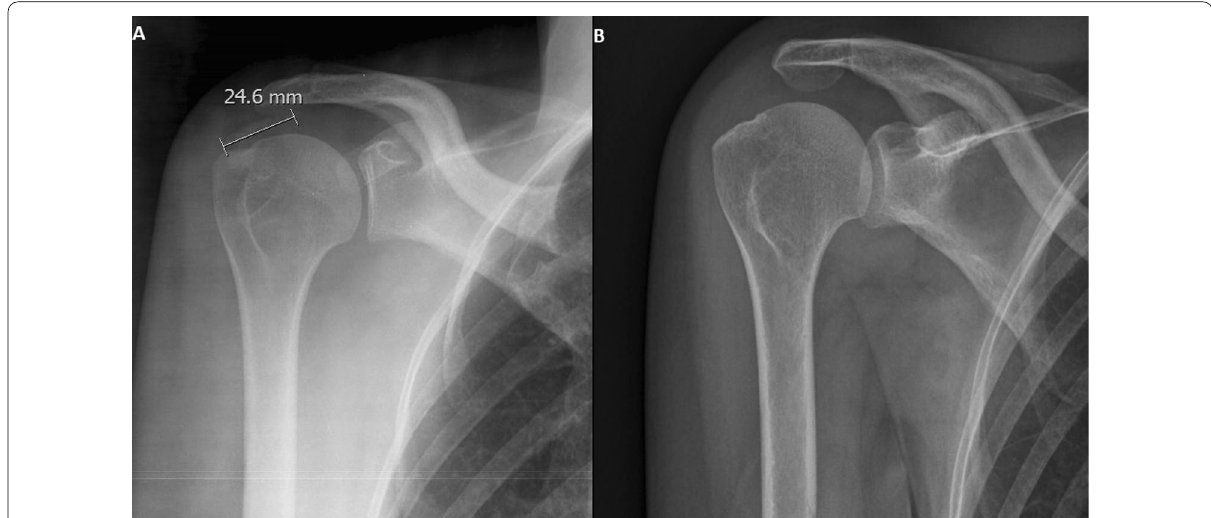
Fig. 3 Anteroposterior shoulder x-ray performed at baseline ( A ) and after 10 years ( B ) shows complete resorption of the calcification